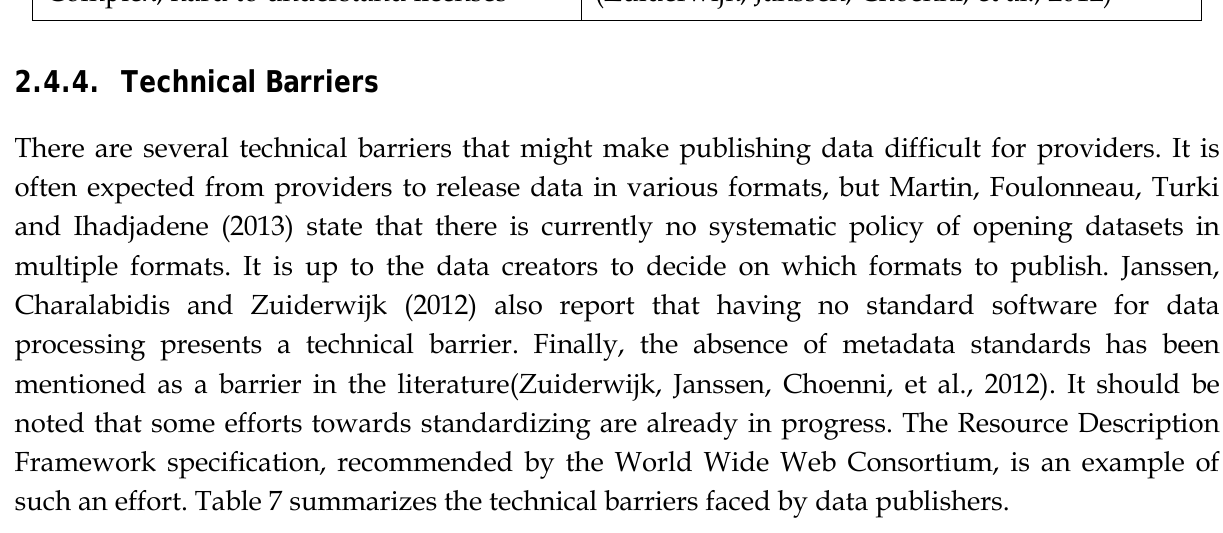
Table 7: Provider Legal Barriers (Source: Authors)